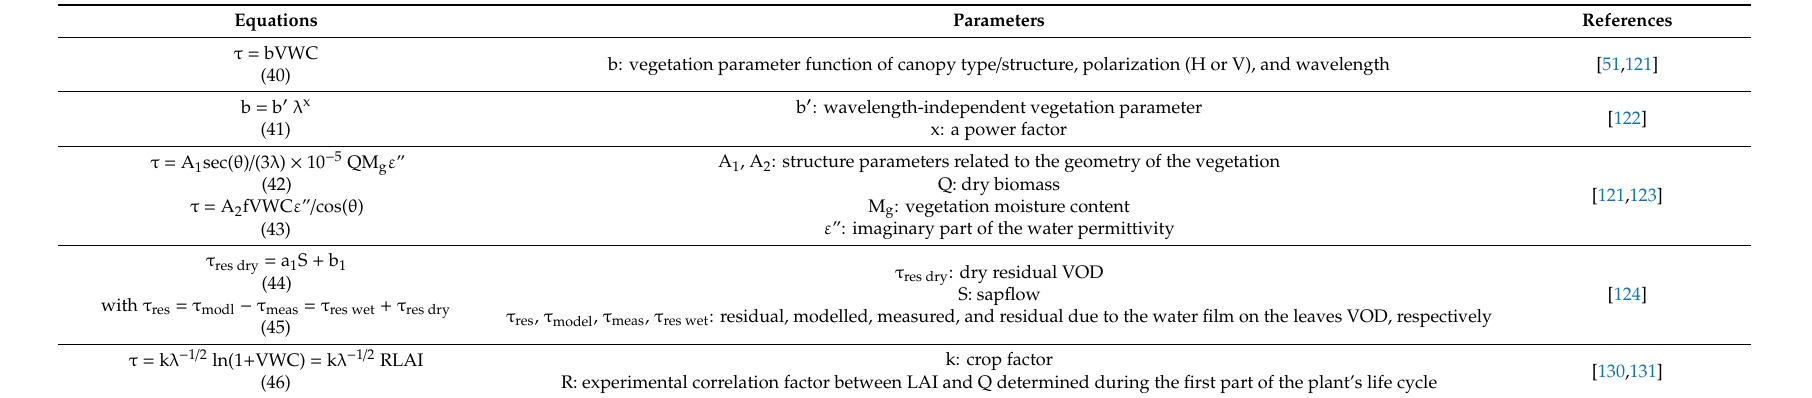
Table 3. Relationships obtained from experimental and theoretical